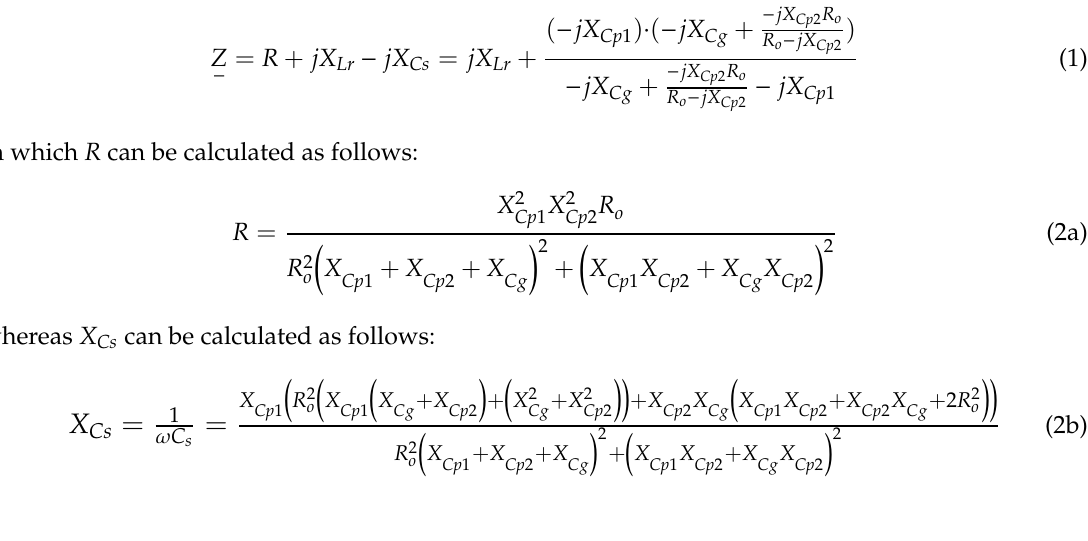
Figure 5. Simplified structural circuit of the mobile CPT system.